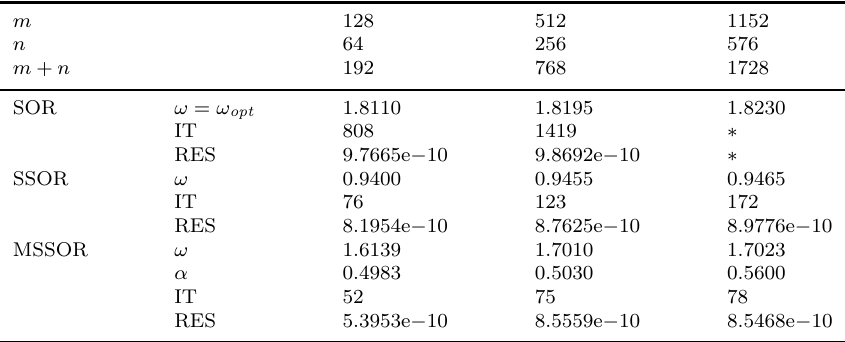
Table 4. The optimum parameters, IT and RES for this example when Q = 10 I ( γ = 10).